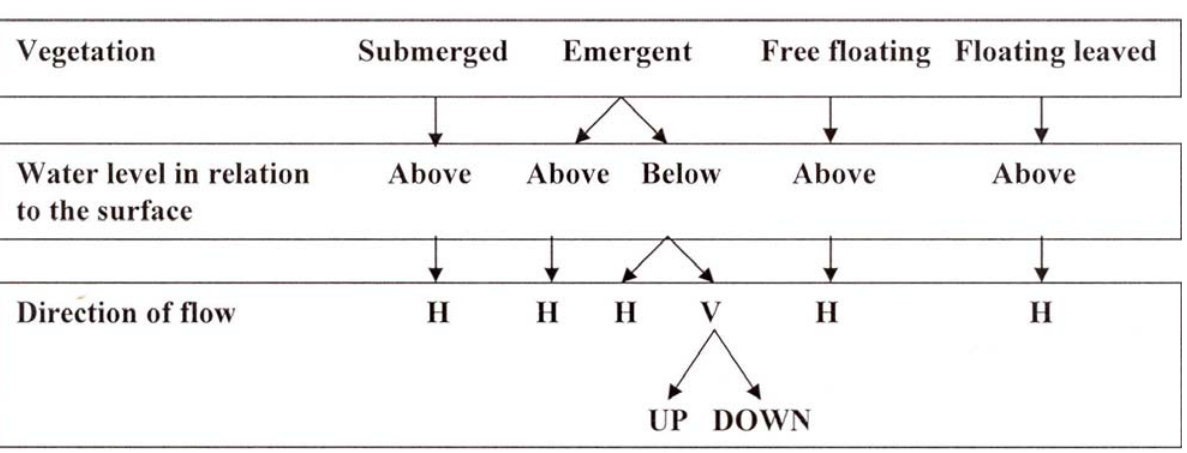
Figure 1. The major characteristics of various types of constructed wetlands for wastewater treatment. H = horizontal, V =